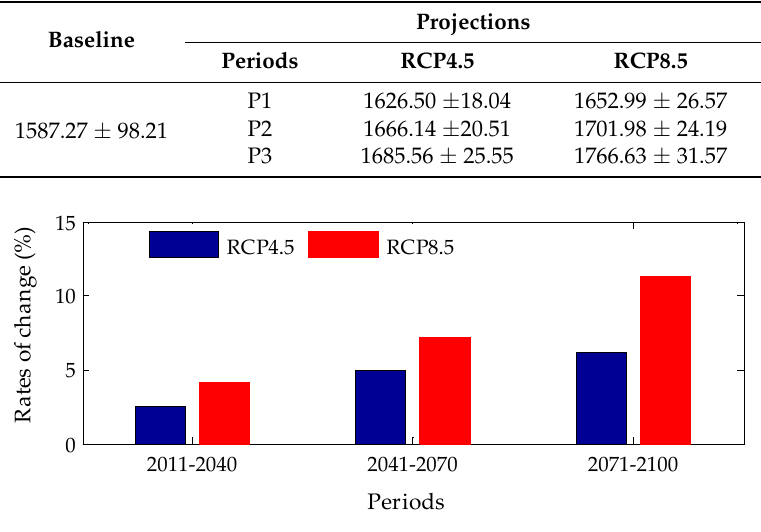
Figure 5. Rates of change of annual PET per projected period and scenario.